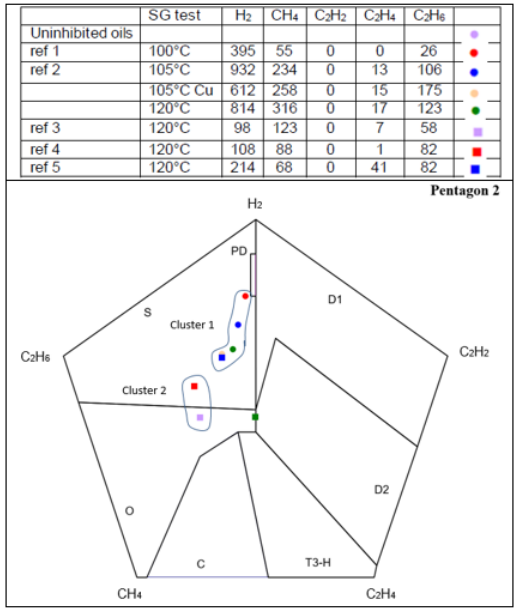
Figure 7. SG of uninhibited mineral oils other than oil B during the SG tests (T < 120 °C) by laboratories other than the FKH, in Clusters 1 and 2.